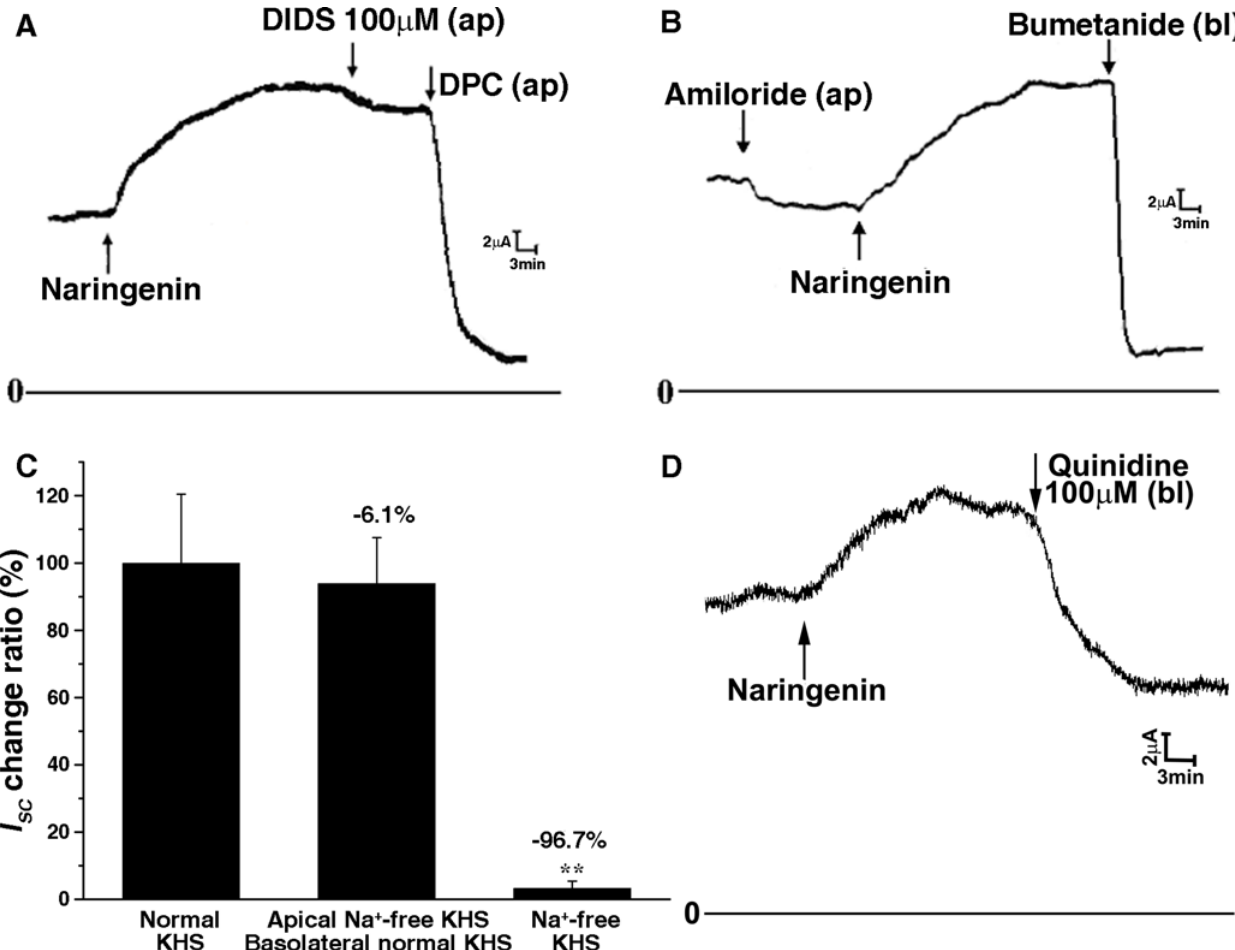
Figure 3. Effect of different channel blockers and bumetanide on Isc evoked by 100 m M NAR in rat colonic mucosa. (A) Stimulation with NAR on basolateral side resulted in an increase in I SC , which is not abolished by DIDS (100 m M, apical), but by apical (ap) application of DPC (1 mM). (B) The NAR induced Isc increases doesn’t change when the tissue was pretreated with amiloride (ENaC blocker, 100 m M), but was abolished by basolateral application of 100 m M bumetanide. (C) Comparison of NAR (100 m M)-induced I SC obtained in control (normal K-H solution), apical Na + - free K-H solution with basal normal K-H solution, Na + -free K-H solution on both sides. (**P , 0.001 vs. control). (D) Qunindine (100 m M, bl) inhibited NAR (100 m M, bl) stimulated I SC .